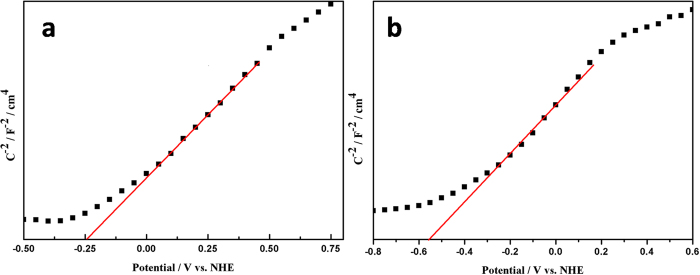
Mott-Schottky plots for (a) TiO2 and (b) (NH4)xWO3 collected at a frequency of 1000 Hz in the dark.